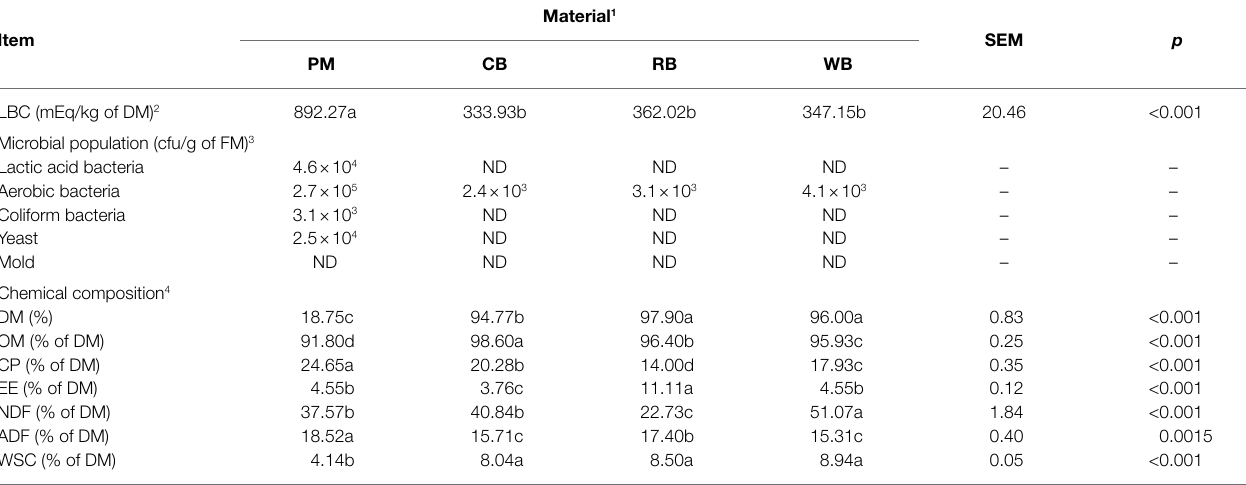
TABLE 1 | LBC, microbial population, and chemical composition data of all assessed material.